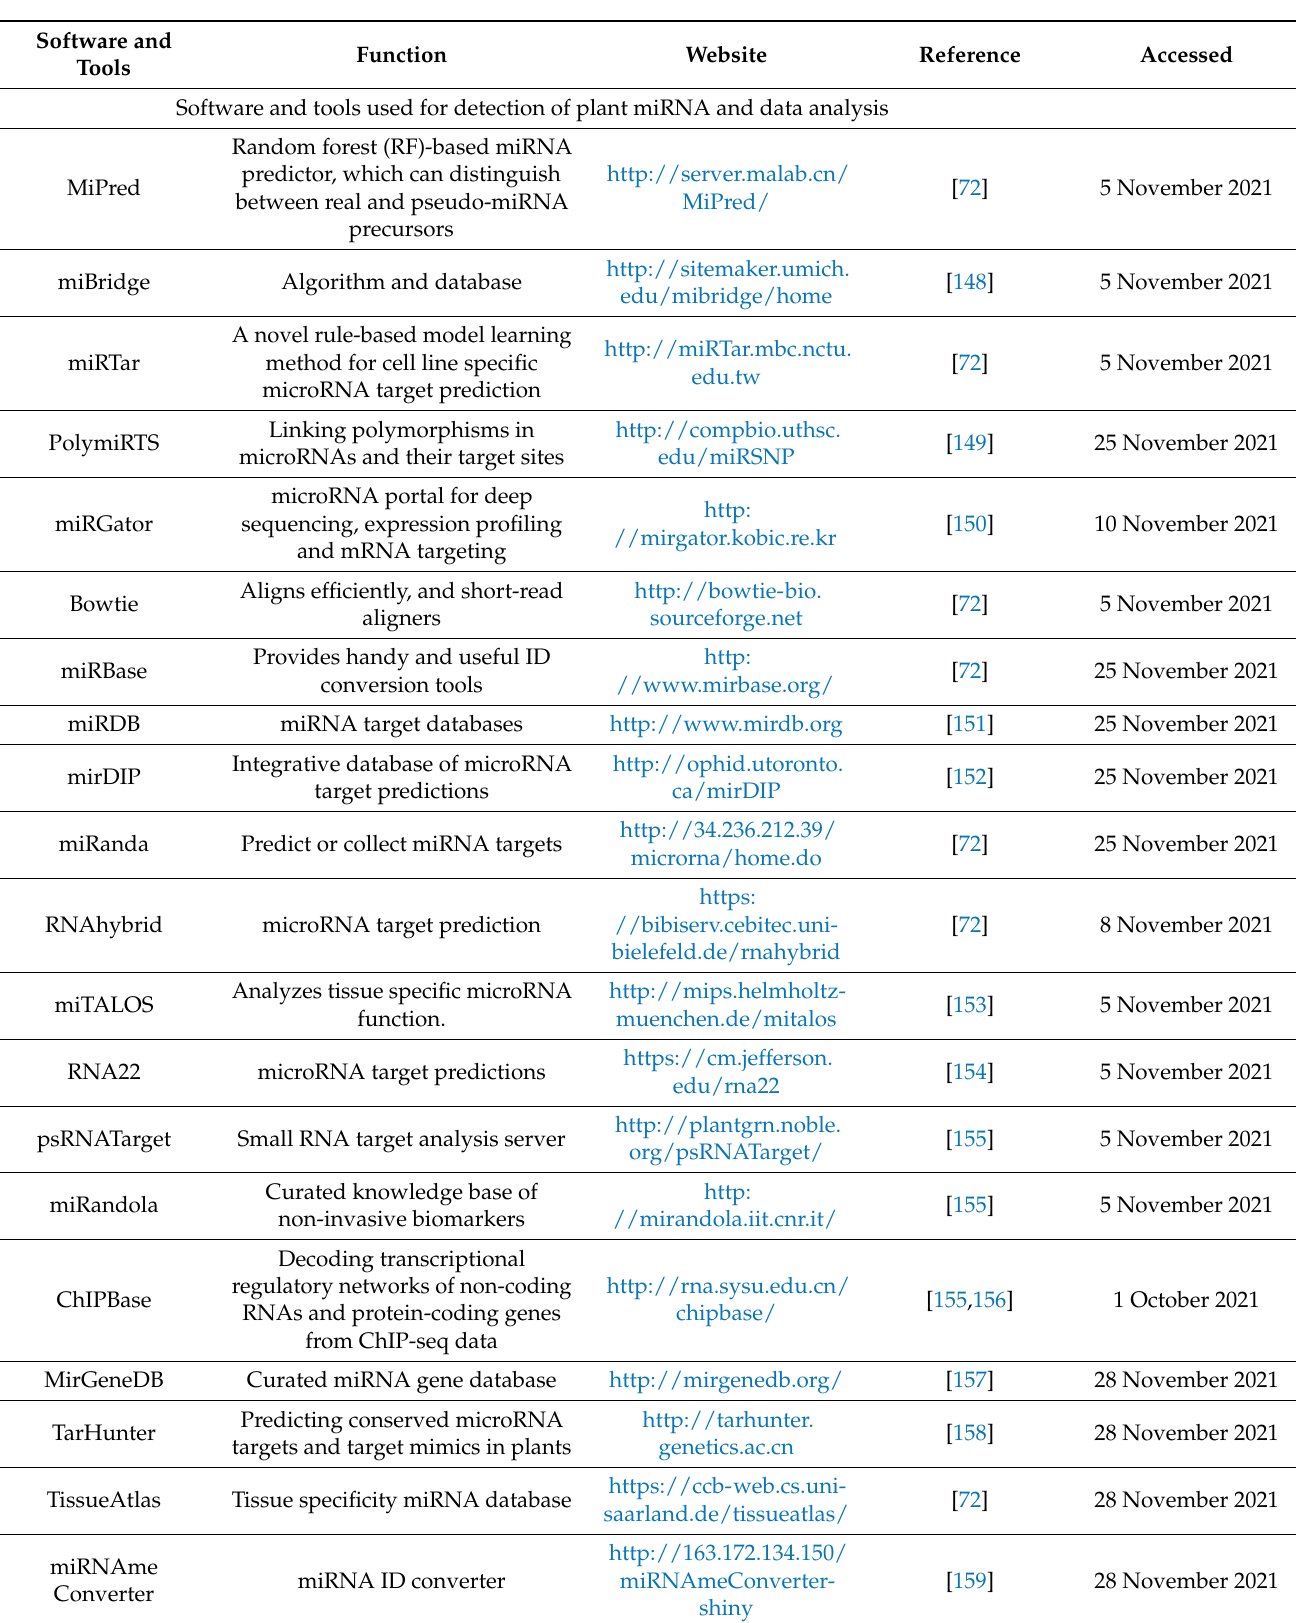
Table 4. Software and tools used for the detection of plant miRNA and cDNA microarray data